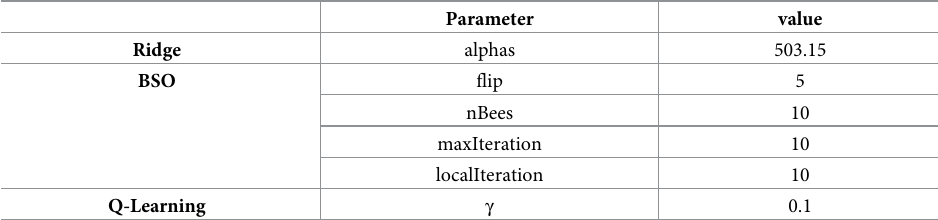
Table 3. Hyper-parameters used by RQBSO